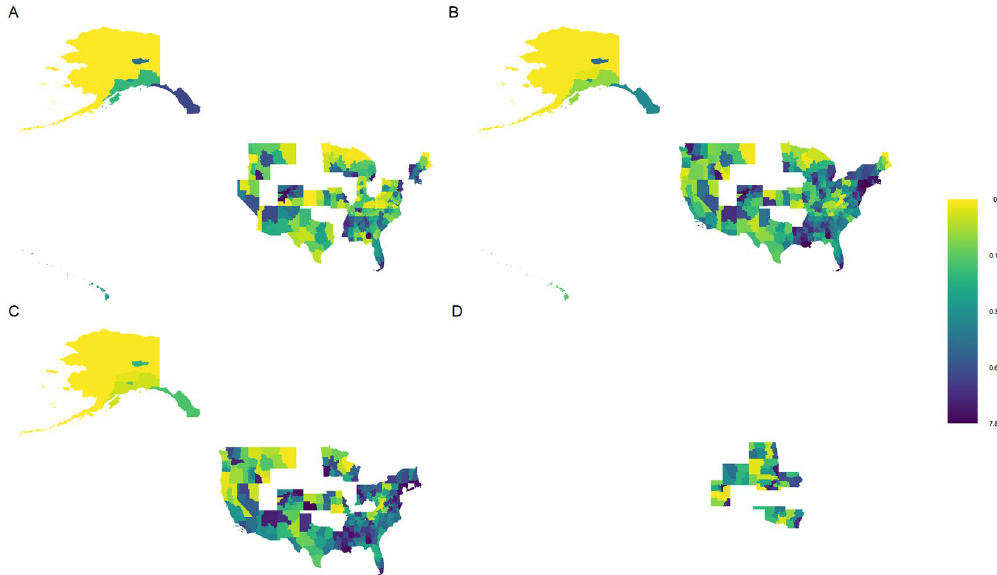
Figure 1. A combination of the stay at home orders variable and standardized incidence ratios by health region for the confirmed cases outcome. ( A ) Before stay at home orders, ( B ) During full stay at home orders, ( C ) During partial stay at home orders, and ( D ) Never stay at home orders. Health regions are only present in panes where the stay at home orders category